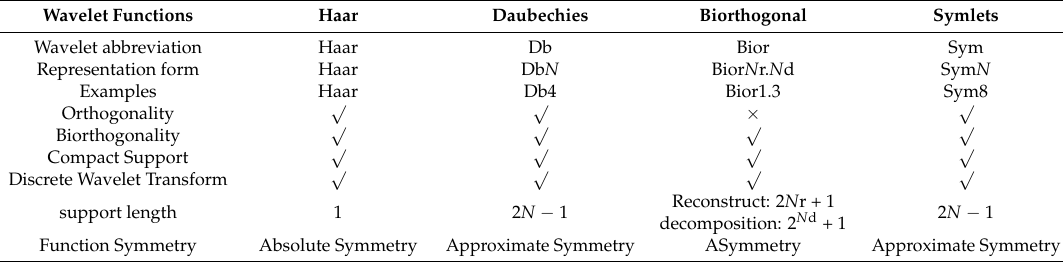
Table 3. Description of common wavelet function